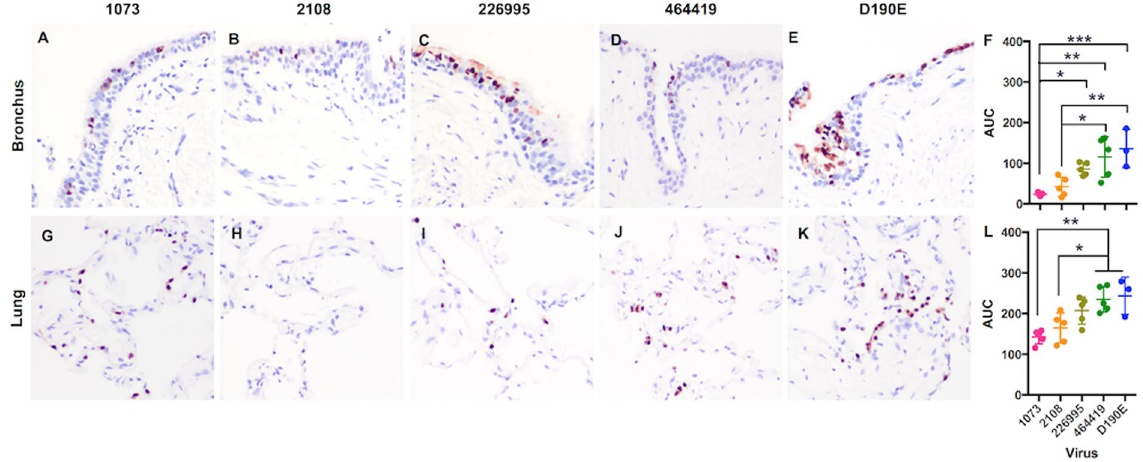
Figure 1. The cellular distribution of influenza nucleoprotein in the human bronchus and lung after the infection of human H9N2 viruses. The cellular localization of viral antigen (reddish brown) in ( A to E ) bronchi, and ( G to K ) lung infected with ( A and G ) A/HK/1073/99 (H9N2), ( B and H ) A/HK/2108/03 (H9N2), ( C and I ) A/HK/226995/08 (H9N2), ( D and J ) A/HK/464419/09 (H9N2) viruses and ( E and K ) A/HK/464419/09-D190E (H9N2) at 24hpi were shown. The chart showed the mean and the SD of the AUC values of each virus pooled from at least three independent experiments of each virus ( F ) in the bronchus and ( L ) in the lung cultures were shown. * p < 0.05; ** p < 0.01; *** p <